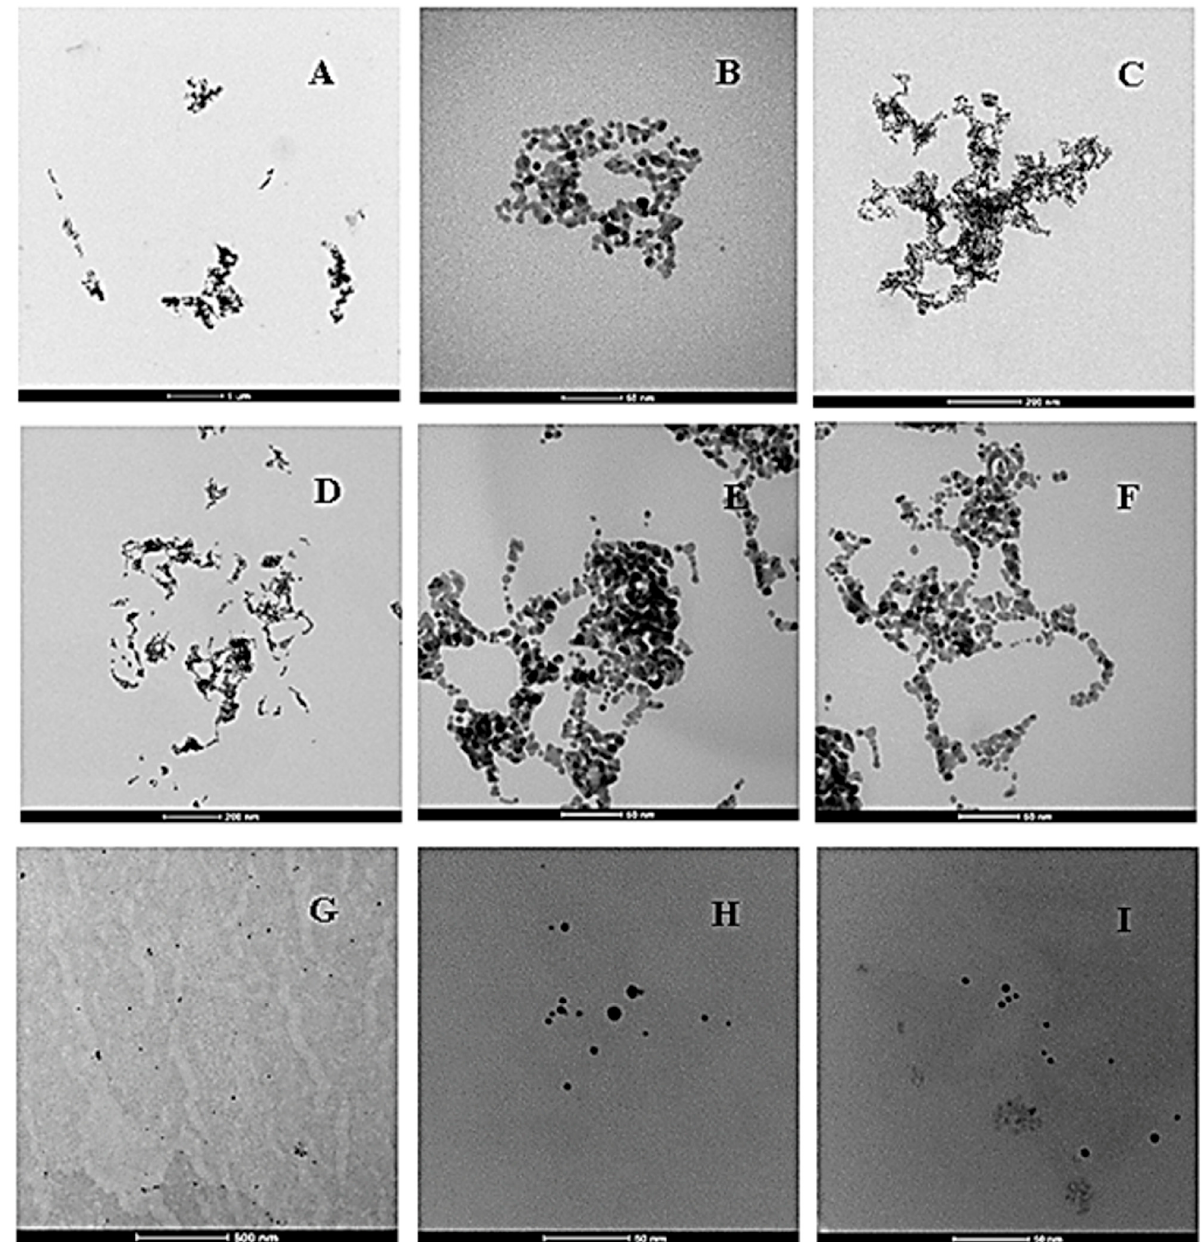
Figure 3. TEM images of aggregation/disaggregation processes for Au@16-s-16 nanoparticles in the presence of monomers and micelles of SDS, C Au@16-3-16 = 1.74 × 10 − 8 M and C Au@16-6-16 = 1.38 × 10 − 8 M in the samples. ( A – C ) Au@16-3-16/SDS system, C SDS = 3.0 × 10 − 5 M; ( D – F ) Au@16-6-16/SDS system, C SDS = 3.0 × 10 − 5 M; ( G , H ) Au@16-3-16/SDS system, C SDS = 1.5 × 10 − 3 M; ( I ) Au@16-6-16/SDS system, C SDS = 1.5 × 10 − 3 M.